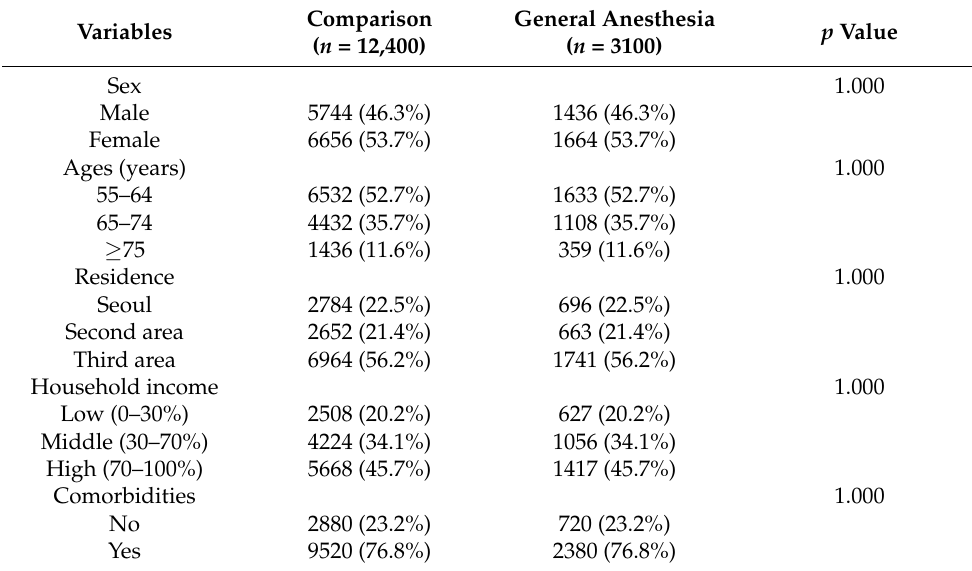
Table 1. Characteristics of the study